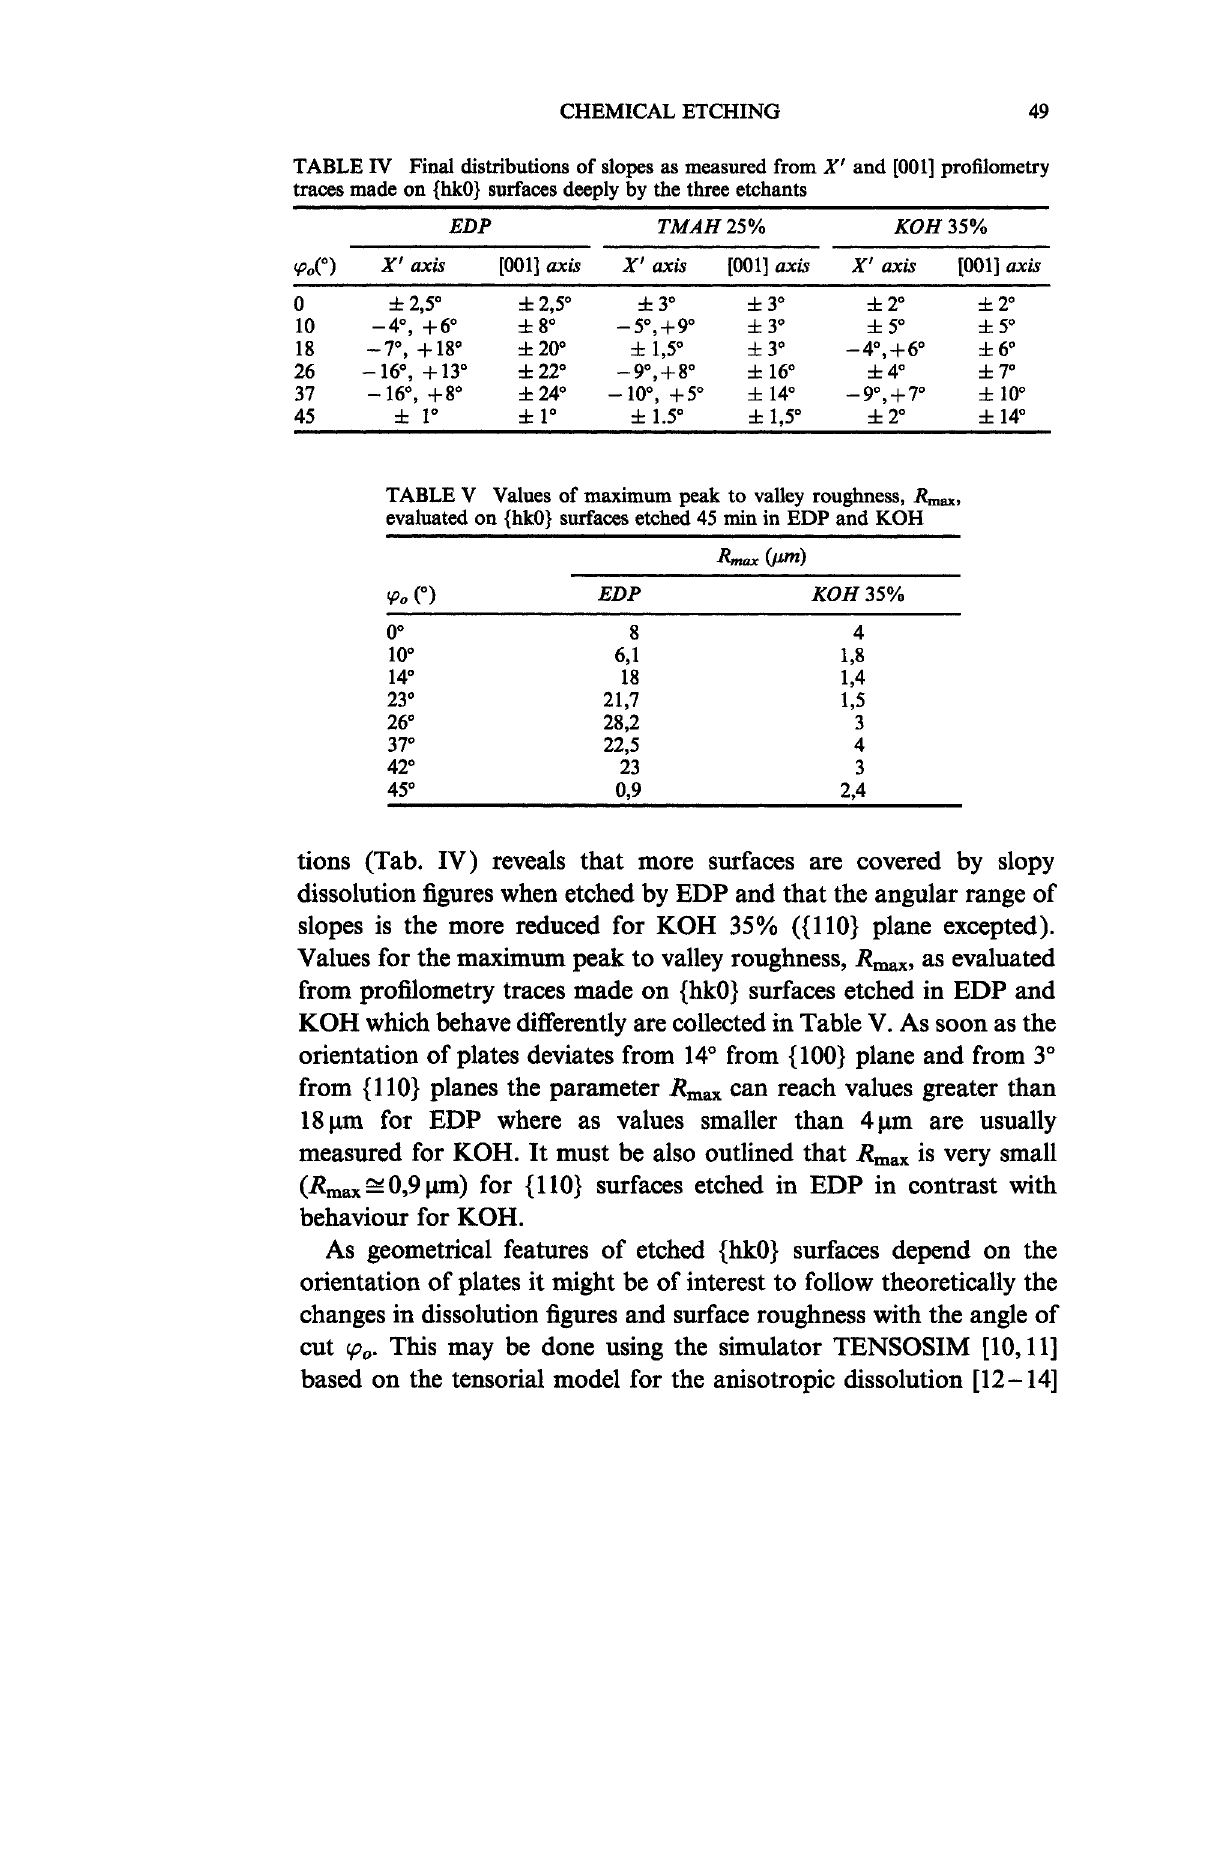
TABLE IV Final distributions of slopes as measured from X’ and [001] profilometry traces made on {hk0} surfaces deeply by the three etchants EDP TMAH 25 % qo() 0